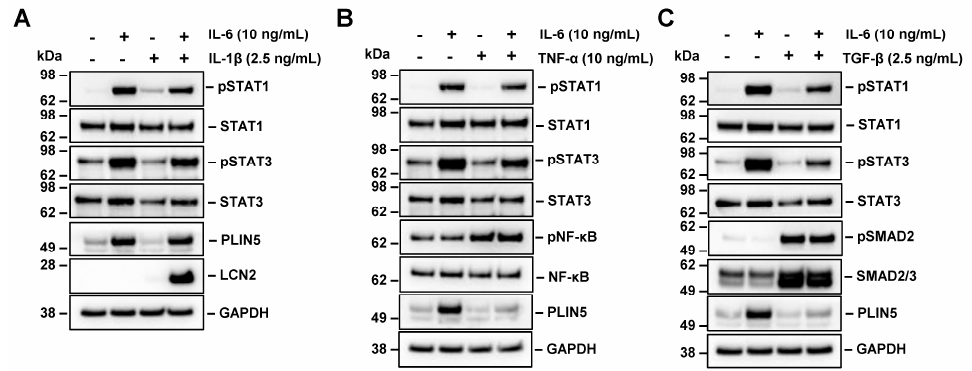
Figure 8. Effect of IL-1 β , TNF- α and TGF- β on IL-6-mediated PLIN5 upregulation in Hep3B cells. ( A – C ) Hep3B cells were treated with IL-6 in combination with IL-1 β , TNF- α and TGF- β for 24 h. PLIN5 expression and phosphorylation of STAT3 analyzed by Western blot demonstrated that ( A ) IL-1 β has no effect on STAT3 signaling and PLIN5 expression while ( B , C ) TNF- α and TGF- β partially block STAT3 phosphorylation and IL-6-induced PLIN5 protein upregulation. GAPDH served as loading